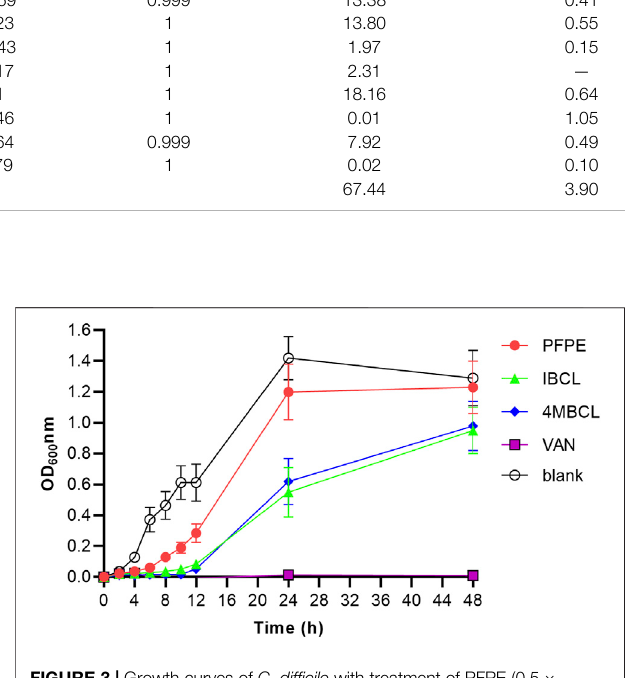
FIGURE 3 | Growth curves of C. dif fi cile with treatment of PFPE (0.5 × MIC, 4 μ g/ml), IBCL (0.5 × MIC, 2 μ g/ml), and 4MBCL (0.5 × MIC, 2 μ g/ml). Vancomycin (1.0 × MIC, 1 μ g/ml) was set as positive control and no-drug treatment group was set as